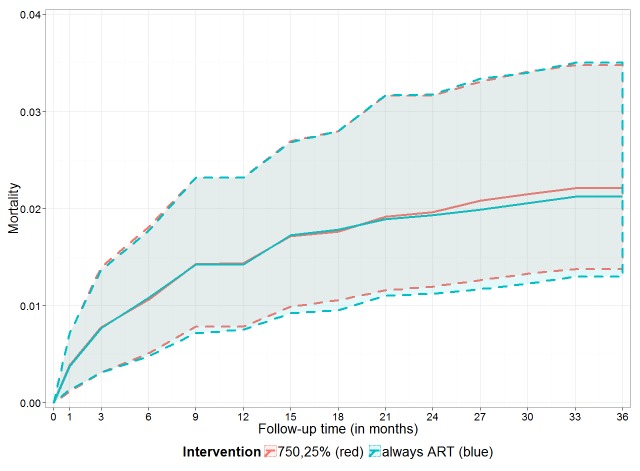
Estimated cumulative mortality for immediate versus deferred ART.Estimated cumulative mortality (including 95% bootstrap CI, dashed lines) over 3 y if ART was given irrespective of CD4 count and CD4% (blue line, “always ART”) and if ART was given if the CD4 count was below 750 cells/mm3 or the CD4% was below 25% (red line, “750,25%”).